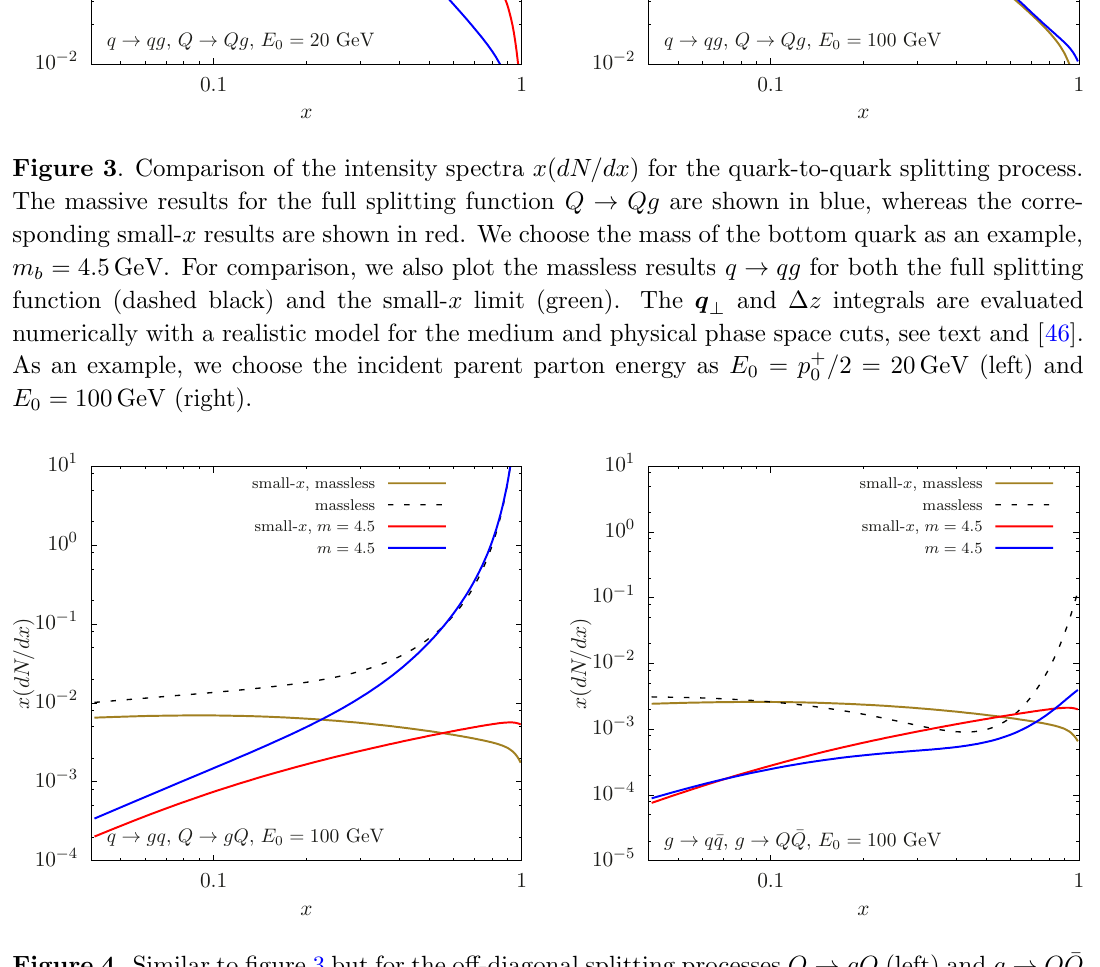
Figure 4 . Similar to (cid:12)gure 3 but for the o(cid:11)-diagonal splitting processes Q ! gQ (left) and g ! Q (cid:22) Q (right) for E 0 = 100